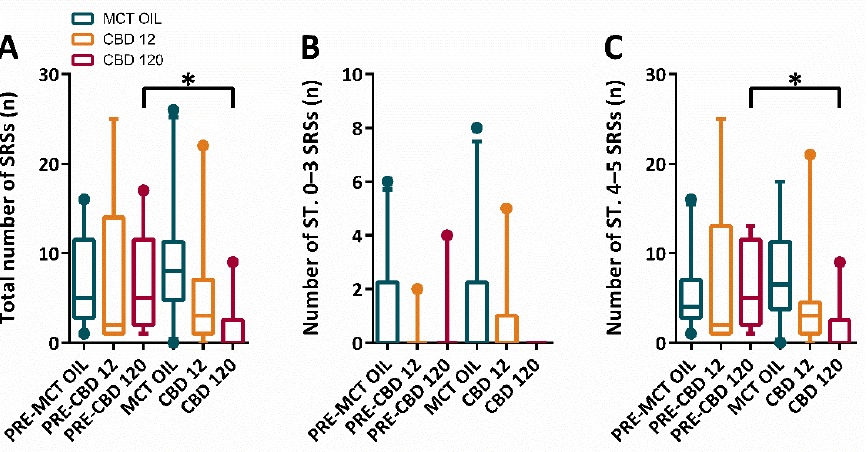
Figure 4. Total number of spontaneous recurrent seizures (SRSs) in epileptic rats treated with cannabidiol (CBD) at 12 mg/kg, 120 mg/kg, or with medium-chain triglyceride (MCT) oil. Rats (n = 30) were treated with CBD 12 mg/kg (n = 10, 2 of which did not display SRSs and were attributed a 0 value), CBD 120 mg/kg (n = 10, 5 of which did not display SRSs and were attributed a 0 value), or MCT oil (n = 10, 1 of which did not display SRSs and were attributed a 0 value). In ( A ), CBD at 120 mg/kg significantly decreased (Tukey test; * p < 0.05, PRE ‐ CBD 120 vs. CBD 120) the total number of SRSs. The high dose of CBD displayed no significant effects on stages (ST.) 0–3 SRSs ( B ), but only on ST. 4–5 SRSs ( C ).